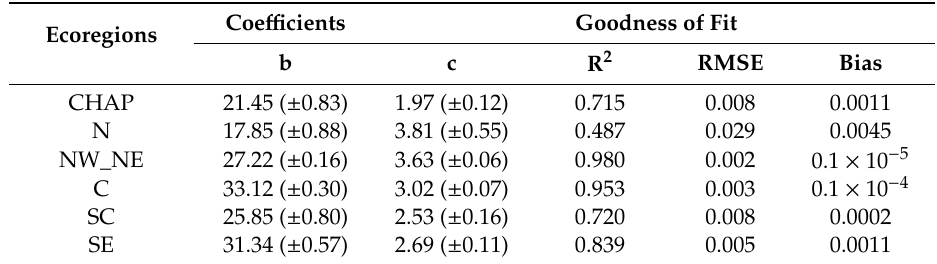
Table 1. Coe ffi cients and goodness-of-fit statistics of the best models for predicting fire occurrence index by biomass level